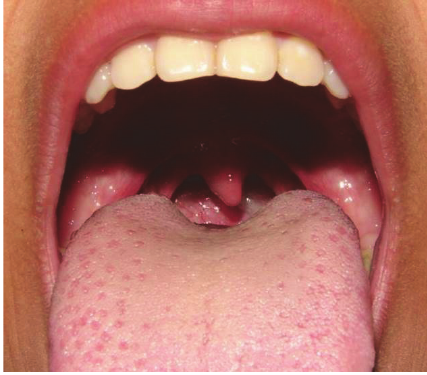
Figure 1: Intraoral physical examination showing a slight nodular lesion at the base of the tongue.